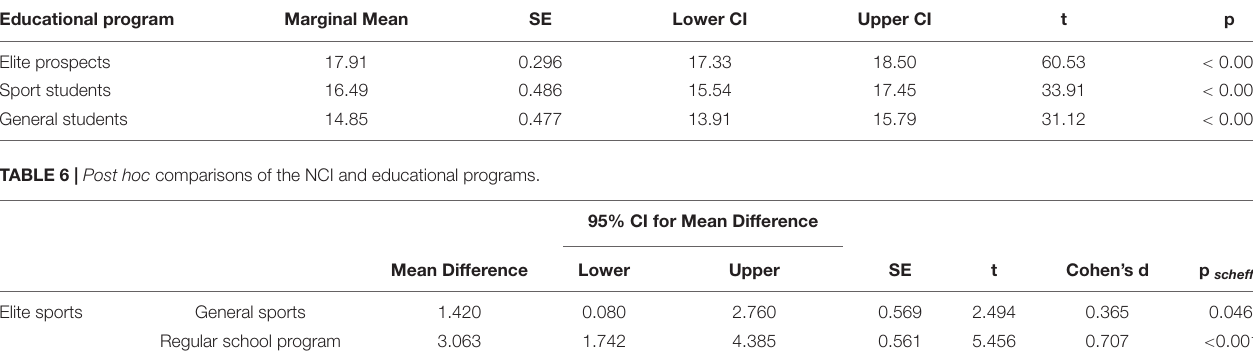
TABLE 5 | Results of the NCI within the respective educational programs.